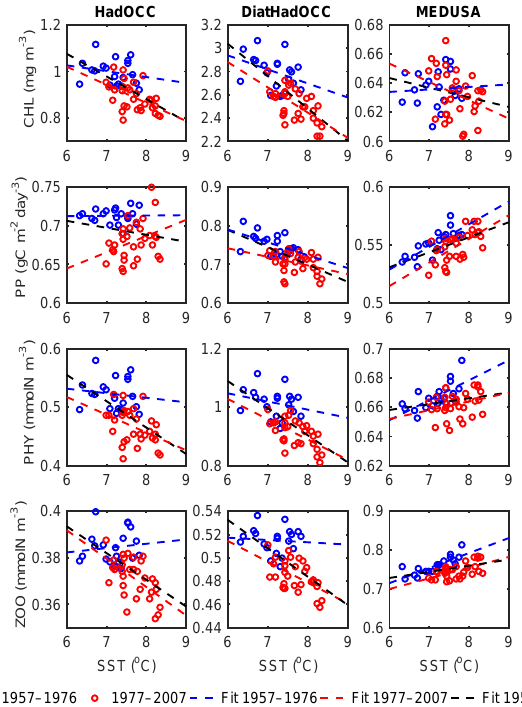
Figure 6. Relationships matrix between simulated sea surface temperature (SST) and the biological variables over the Gulf of Alaska region. Columns represent different models (HadOCC, DiatHadOCC and MEDUSA) and rows represent different biolog- ical variables (surface chlorophyll (CHL), integrated primary pro- duction (PP), total surface phytoplankton (PHY) and zooplankton biomass (ZOO)). Linear relationships are inferred for the periods 1957–1976, 1977–2007 and 1957–2007 using least square regres- sion. Table 5 presents test results on the similarity of these relation-